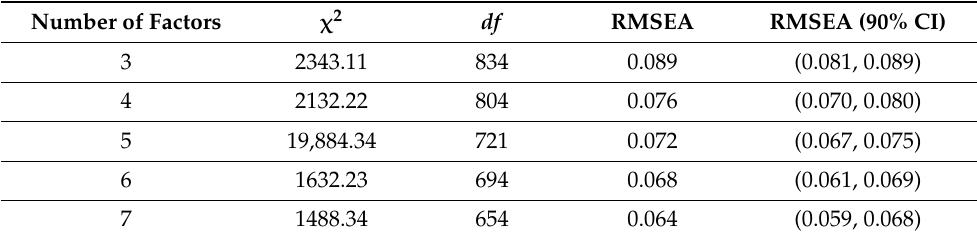
Table 11. Comparison of Factors’ Fit.